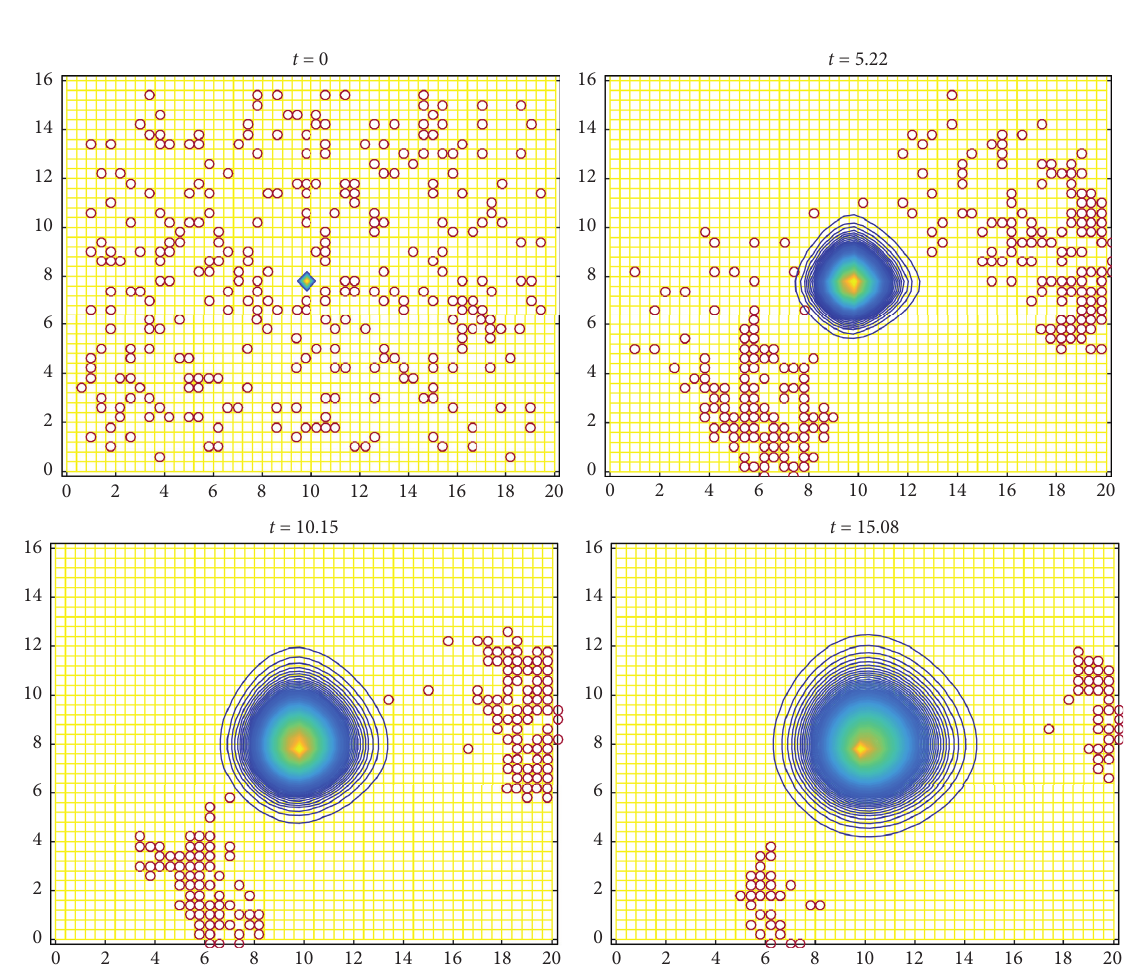
Figure 5: The movements of 300 pedestrians during smoke spreading, where the source is in the middle of the room. The velocity field ,w ) of the advection-diffusion equation (4) is chosen randomly out of the interval [− 0 . 5 , 0 . 5 ] ( w 1 2